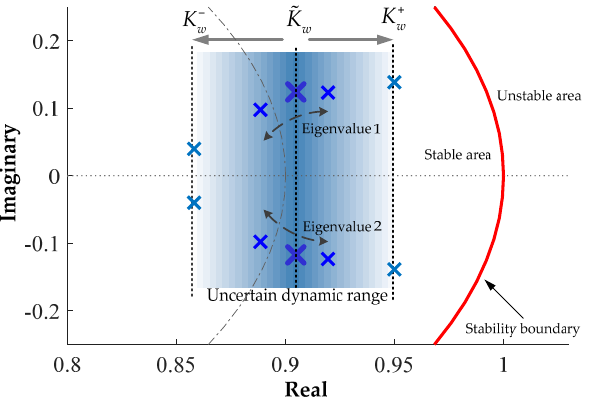
Figure 10. Closed-loop eigenvalue location within uncertain ranges of K w .